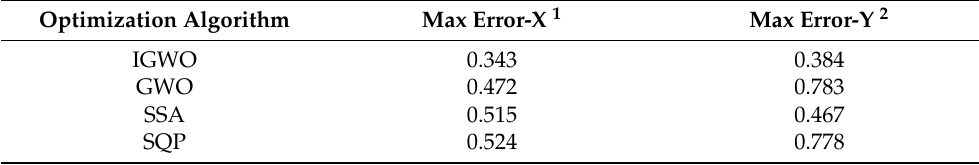
Table 4. Table of maximum absolute tracking error in each direction of algorithms. Optimization